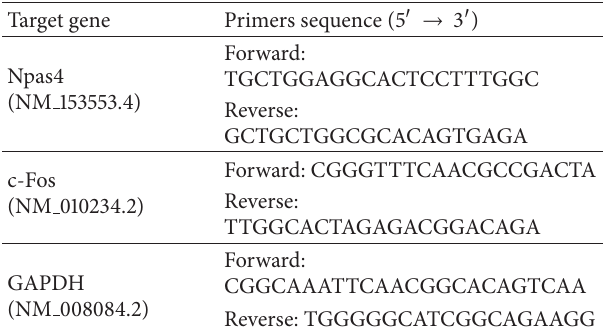
Table 1: Sequences of primers used in real-time